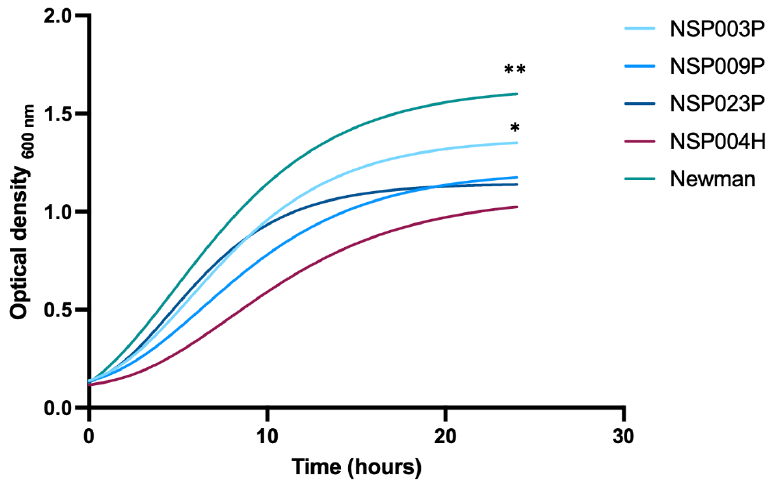
Figure 3. Growth curves of four S. pettenkoferi strains compared to S. aureus Newman strain using the Gompertz equation. A Wilcoxon test was used to compare the slopes of all S. pettenkoferi strains vs. S. aureus Newman; significant difference was at ** p < 0.01. A Dunn test was used to compare growth rates between the S. pettenkoferi strains; significant difference was observed between NSP004H and NSP003P at * p < 0.05.